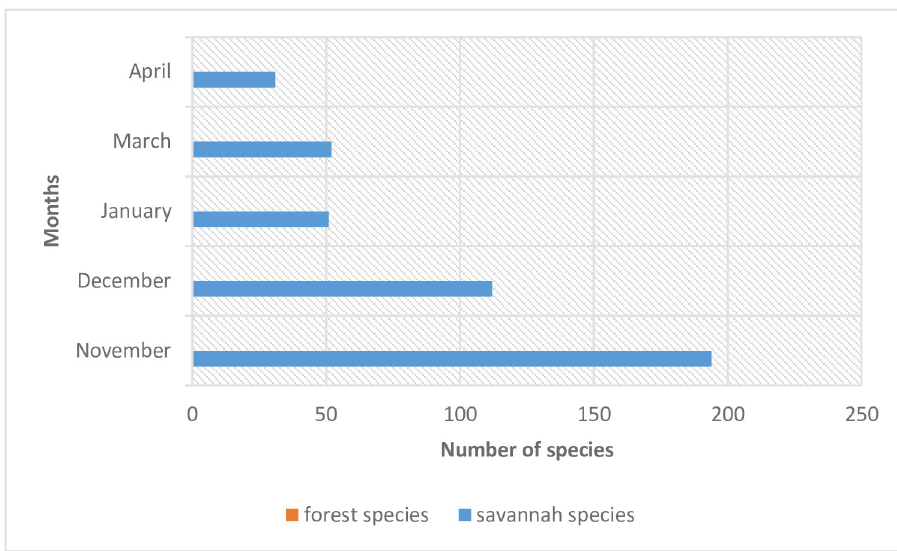
Fig 3. Monthly distribution of species into forest and savannah in the study